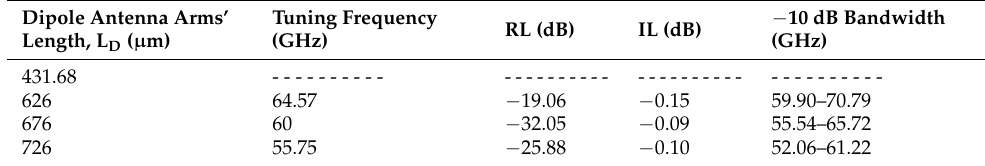
Table 4. Dipole antenna arms’ width variations.